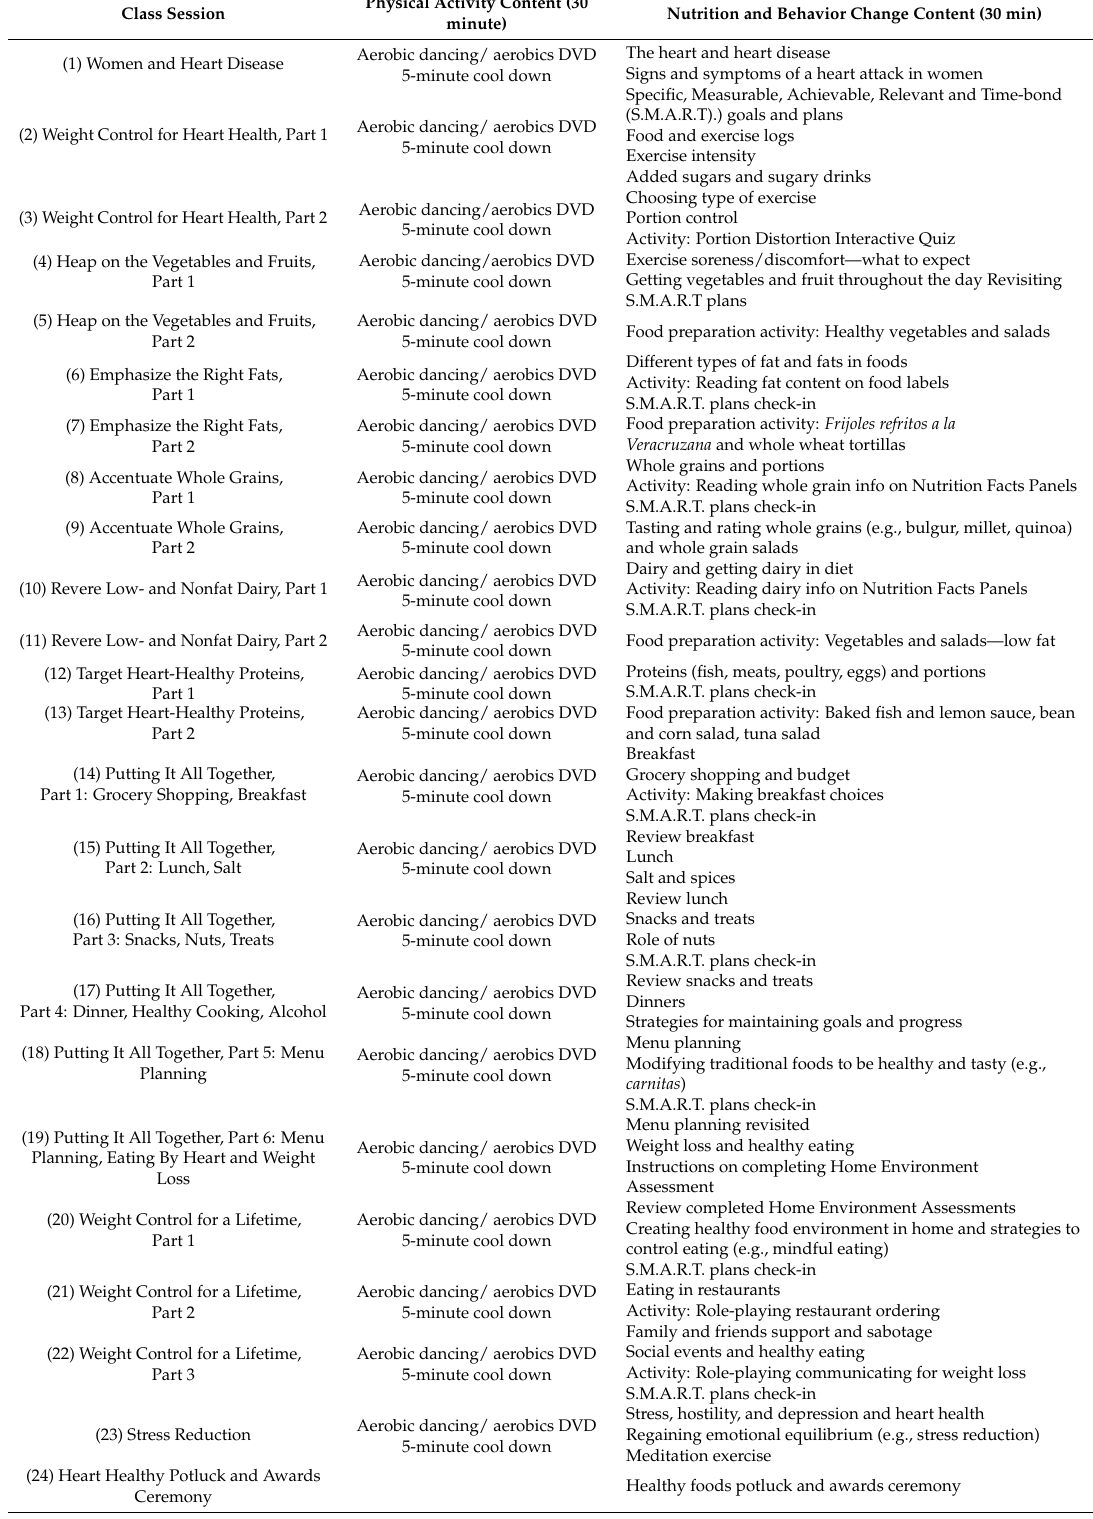
Table 1. Mujeres Fuertes y Corazones Saludables class